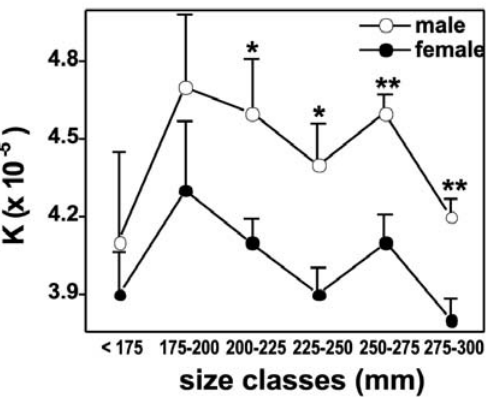
Fig. 1. Means and standard errors (vertical lines) for condition (K) by sex and size classes for Geophagus brasiliensis in the Lajes Reservoir. Between-sex significant differences: * p < 0.05; ** p < 0.01.